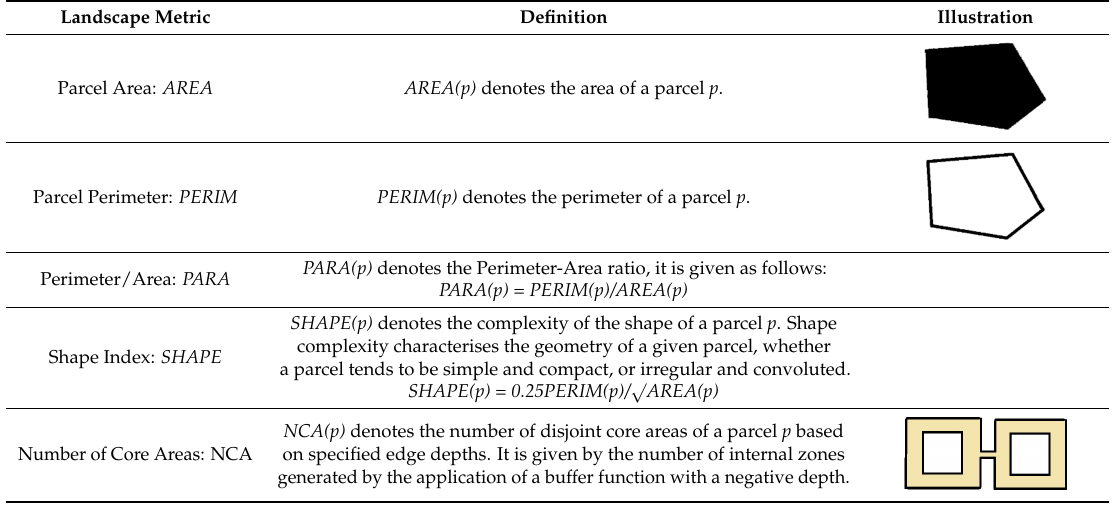
Table 4 . Geometric measures applied to urban paths. Geometric